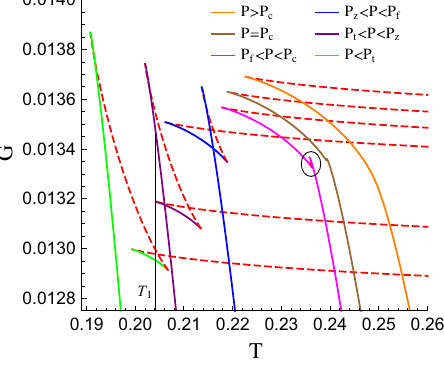
Fig. 2 G – T diagram for different regions of pressure. The right panel indicates a close-up of the zeroth order SBH–LBH phase transition located at the small circle in the left panel. The solid lines correspond to C P > 0 whereas the dashed red lines are related to C P < 0. At the